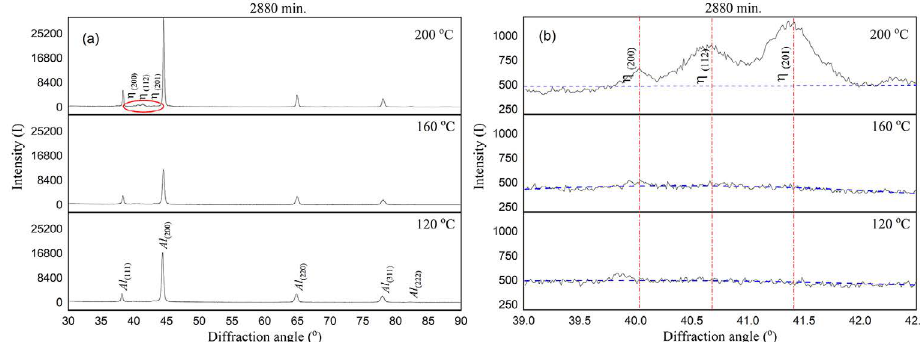
Figure 7. XRD results from samples aged for 2880 minutes at different aging temperatures, a) Peaks obtained between 30- 90º scanning angles from specimens aged for 2880 minutes, b) Zoomed image (39- 42.5 scanning angles)